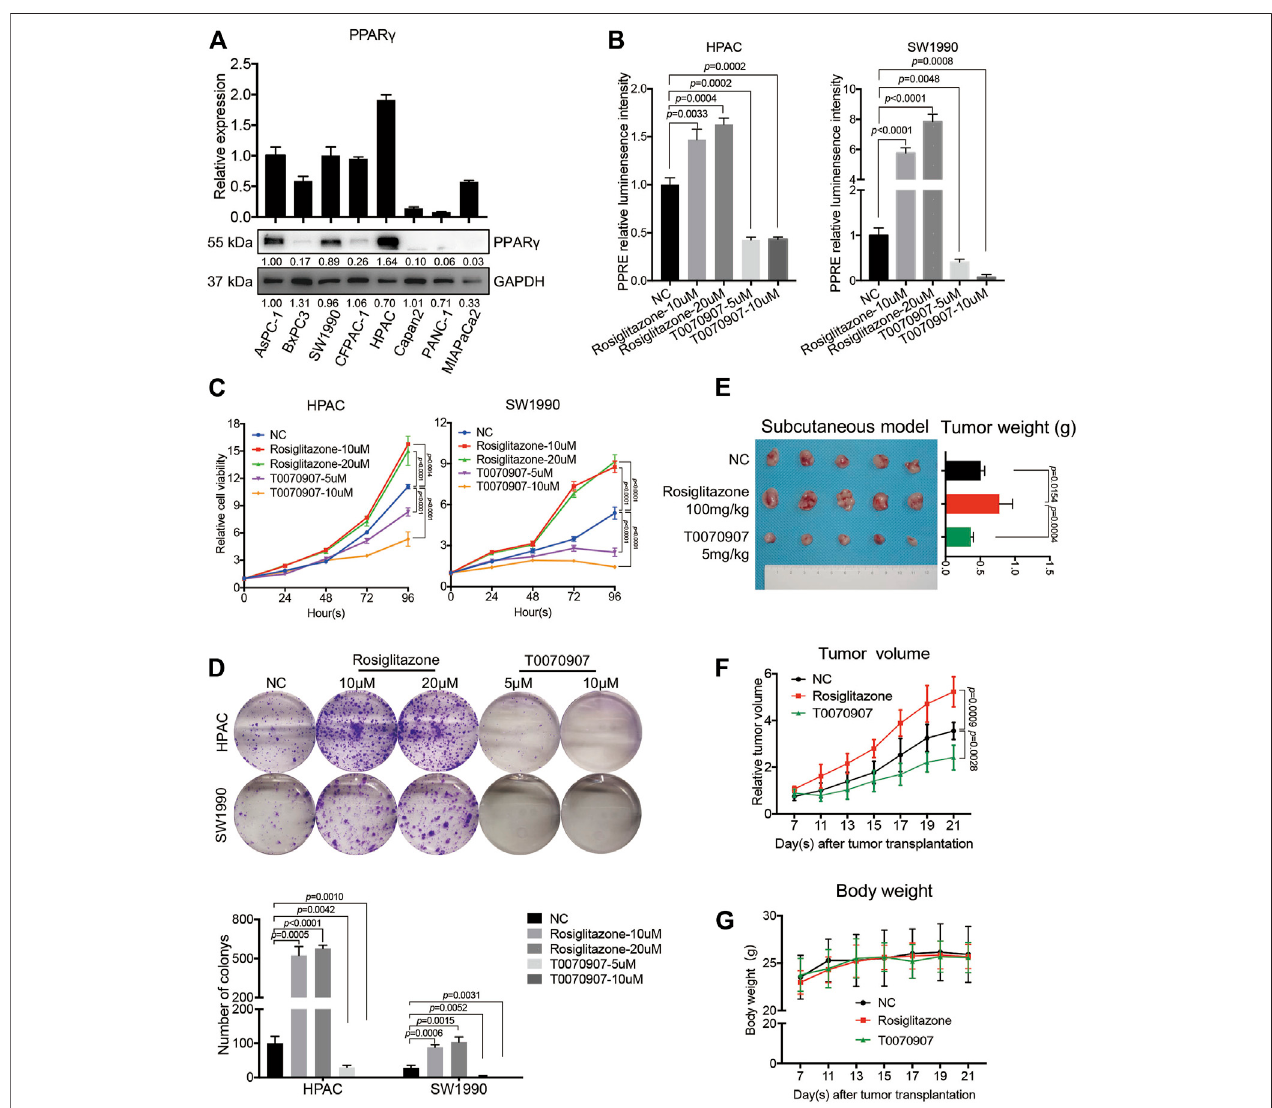
FIGURE 2 | PPAR γ promotes pancreatic cancer cell proliferation in vitro and in vivo. (A) The expression status of PPAR γ was detected in eight human pancreatic cancer cell lines at mRNA and protein levels. (B) The PPRE-driven luciferase reporter gene assay showed Rosiglitazone could activate, while T0070907 could inhibit PPAR γ transcriptionalactivity. (C) RelativecellviabilityofHPACandSW1990cellstreatedwithnegativecontrol,Rosiglitazone(10,20 μ M)orT0070907(5,10 μ M)for0, 24, 48 and 72 h. (D) Formation of colonies of HPAC and SW1990 cells treated with negative control, Rosiglitazone (10, 20 μ M) or T0070907 (5, 10 μ M) for 72 h (E – G) Compared with the control group, administrating nude mice with Rosiglitazone (100 mg/kg) or T0070907 (5 mg/kg) reduced or increased the tumor weight (E) and the tumor volume (F) 4 weeks after HPAC cells injection, without the in fl uence on body weight of mice (G) . Experiments were repeated at least three times, with statistical analyses being reported